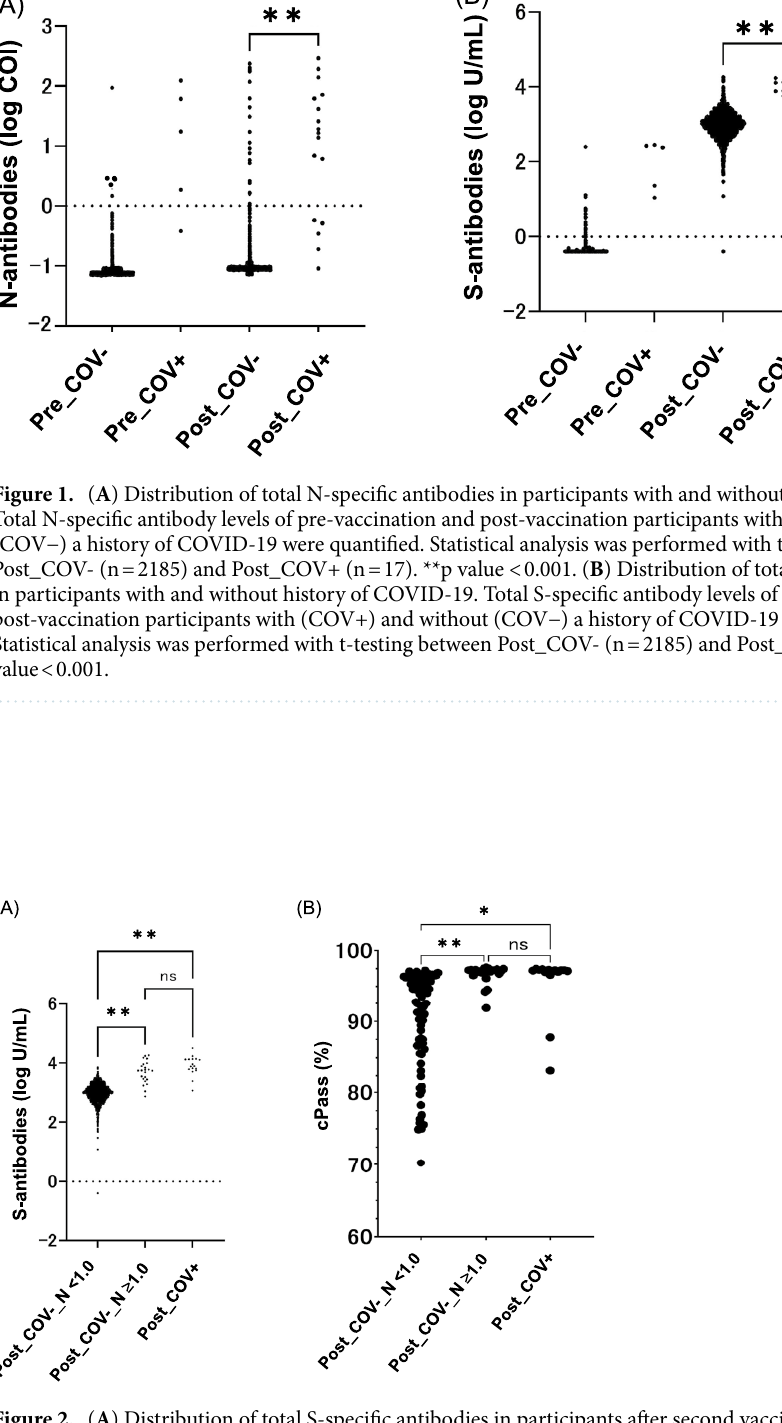
Figure 2. ( A ) Distribution of total S-specific antibodies in participants after second vaccination by N-specific antibody levels. Total S-specific antibody levels were quantified. Statistical analysis was performed with one-way ANOVA among N-negative post-vaccination participants without a COVID-19 history (Post_COV−_N < 1.0) (n = 2162), N-positive post-vaccination participants without a COVID-19 history (Post_COV−_N ≥ 1.0) (n = 23), and post-vaccination participants with a COVID-19 history (Post_COV+) (n = 17). **p value < 0.001. ns, no significant difference. ( B ) Distribution of cPass surrogate neutralizing antibody test values in participants after second vaccination by N-specific antibody levels. Surrogate neutralizing antibody values were quantified. Statistical analysis was performed with one-way ANOVA among N-negative post-vaccination participants without a COVID-19 history (Post_COV−_N < 1.0) (n = 86), N-positive post-vaccination participants without a COVID-19 history (Post_COV−_N ≥ 1.0) (n = 24), and post-vaccination participants with a COVID-19 history (Post_COV+) (n = 15). **p value < 0.001. *p value < 0.05. ns, no significant